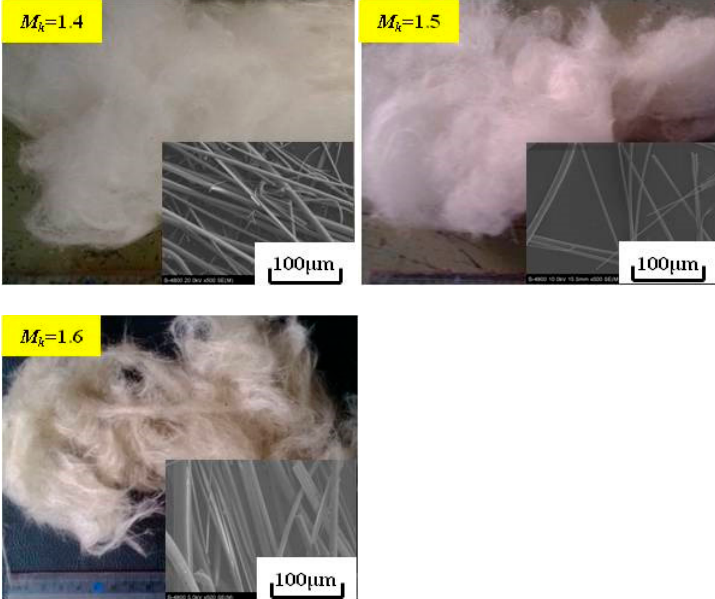
Figure 11. The appearance of the slag fibers prepared from the modified blast furnace slags with different M k values.